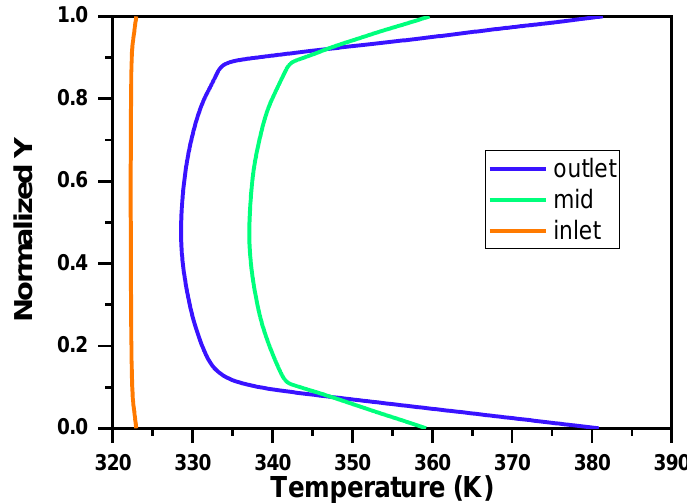
Figure 14. Temperature distribution along the inlet, mid, and outlet of the coolant channel. The temperature contours for the convex sides of the fuel plate (containing fuel and clad) are shown in Figures 15 and 16, respectively. Temperature contours are used to analyze the heat flow in the fuel plate. They can be used to identify areas of high and low thermal conductivity, as well as areas where the fuel plate is being heated or cooled too quickly. The maximum temperature in the convex and concave sides of the fuel regions were 391.76 and 390.39 K, respectively. The maximum temperature attained in the convex and concave sides of aluminum-clad regions were 389.92 and 388.54 K, respectively. By considering the generated heat in the hottest fuel plate of the MSTR-HPC core, the determined temperature for fuel plate regions was below the safety limits. The safety limits to be considered from the safety point of view are the U-10Mo melting point (1150 °C = 1423.15 K), the delamination limits of U-10Mo plate-type fuel (~ 550 °C = 823.15 K), and the clad melting points (660 °C = 933.15 K) [28,29]. The velocity and pressure profiles are shown in Figures 17 and 18, respectively. At the coolant inlet, velocity started at 0.664 m/s and increased towards 0.8 m/s at the outlet of the coolant channel. The presented pressure profile is gauge pressure. The determined pressure difference (outlet to inlet) was 520 Pascal. At full operation power of the HPC core, the mass flow rate of 39.86 kg/s (10.644 gallon/s) was sufficient for removing the generated heat. An average pumping system in the current market can produce such a requirement. However, a pumping system with higher capacity can add extra safety assurance for removing the generated heat in the HPC core.